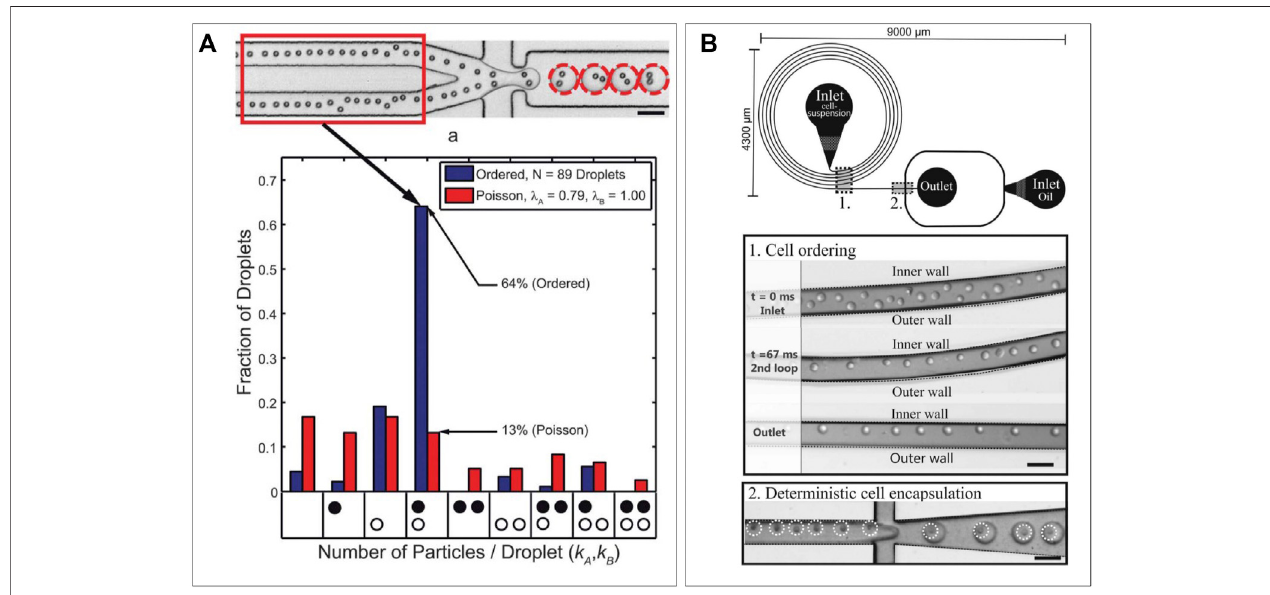
FIGURE 4 | Deterministic encapsulation. (A) Radial displacement leading to a particle train which can be synced with frequency of production rate to obtain increased cell-pairing ef fi ciency (Lagus et al., 2013). (B) Deans fl ow in spiral shaped channels can form particle trains on the inner wall, which can be used to obtain deterministic encapsulation (Kemna et al.,